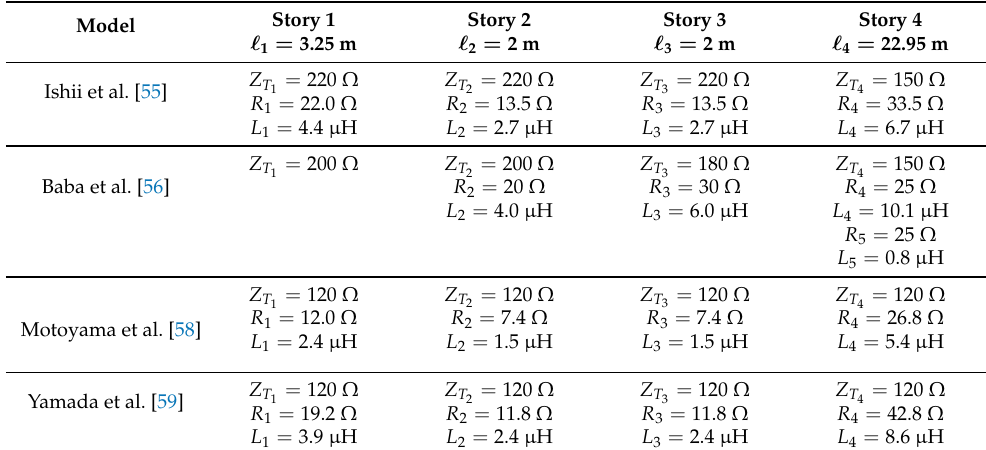
Table 5. Typical values of characteristic impedances and lumped elements for the reference tower (a) in Figure 16 according to multistory models presented in Section